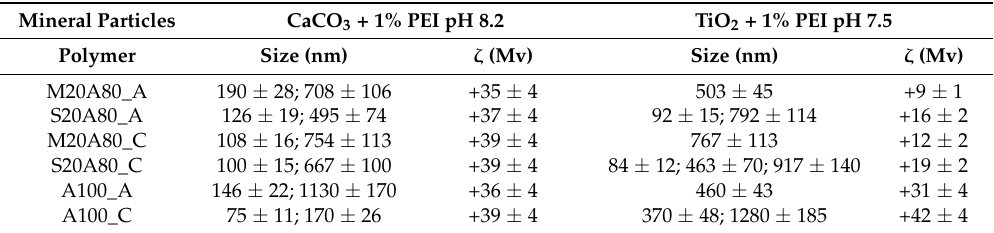
Table 2. Size and ζ -potential values for the mixed dispersions containing cetyltrimethylammonium bromide (CTAB)-stabilised latexes and TiO 2 or CaCO 3 nanopowders dispersed in 1% PEI (with respect to the polymer solids) at pH 7.5 (TiO 2 ) and 8.2 (CaCO 3 ). Mineral Particles CaCO 3 + 1% PEI pH